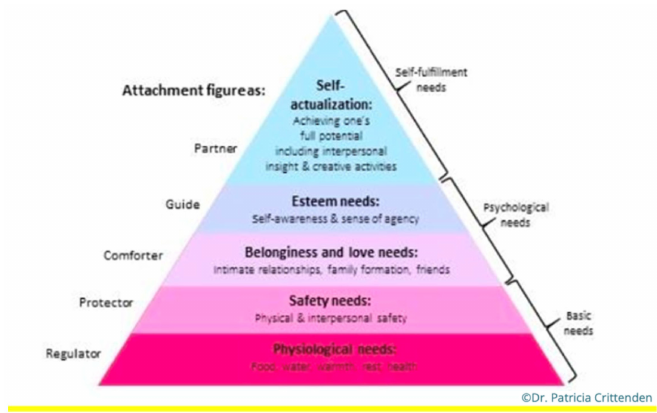
Figure A2. DMM version of Maslow’s Hierarchy of Needs. Permission